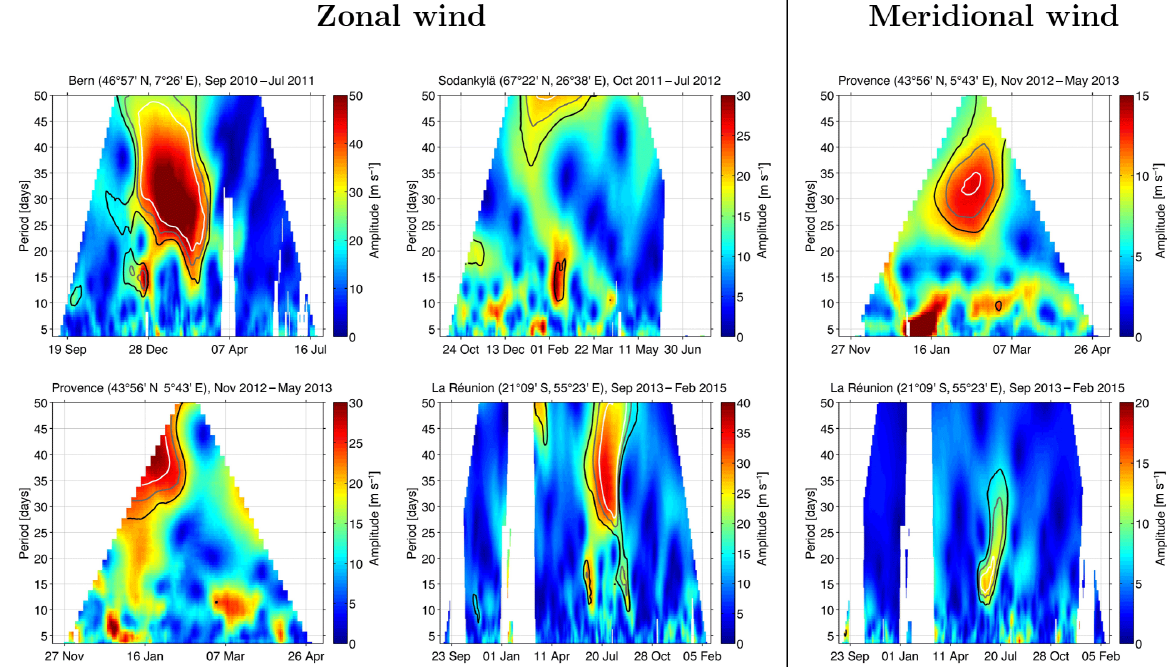
Figure 4. As Fig. 3 but for the unaltered daily average wind data from the ECMWF operational